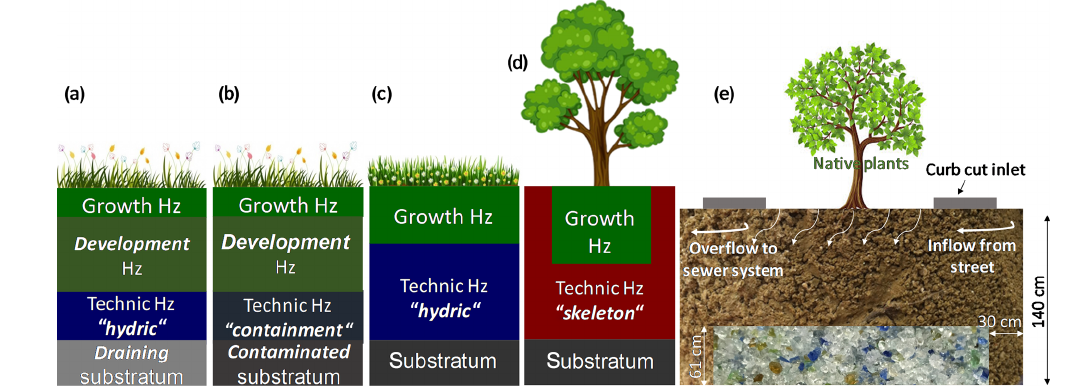
Figure 3. Examples of the organization of horizons in constructed Technosols noted in the literature for (a–b) extensive grassland (Biotech- nosol project), (c) parks and square lawns, (d) tree-lined streets ( c and d from the SITERRE project), and (e) the storm water management system (DEPNY, 2010). Note: Hz –